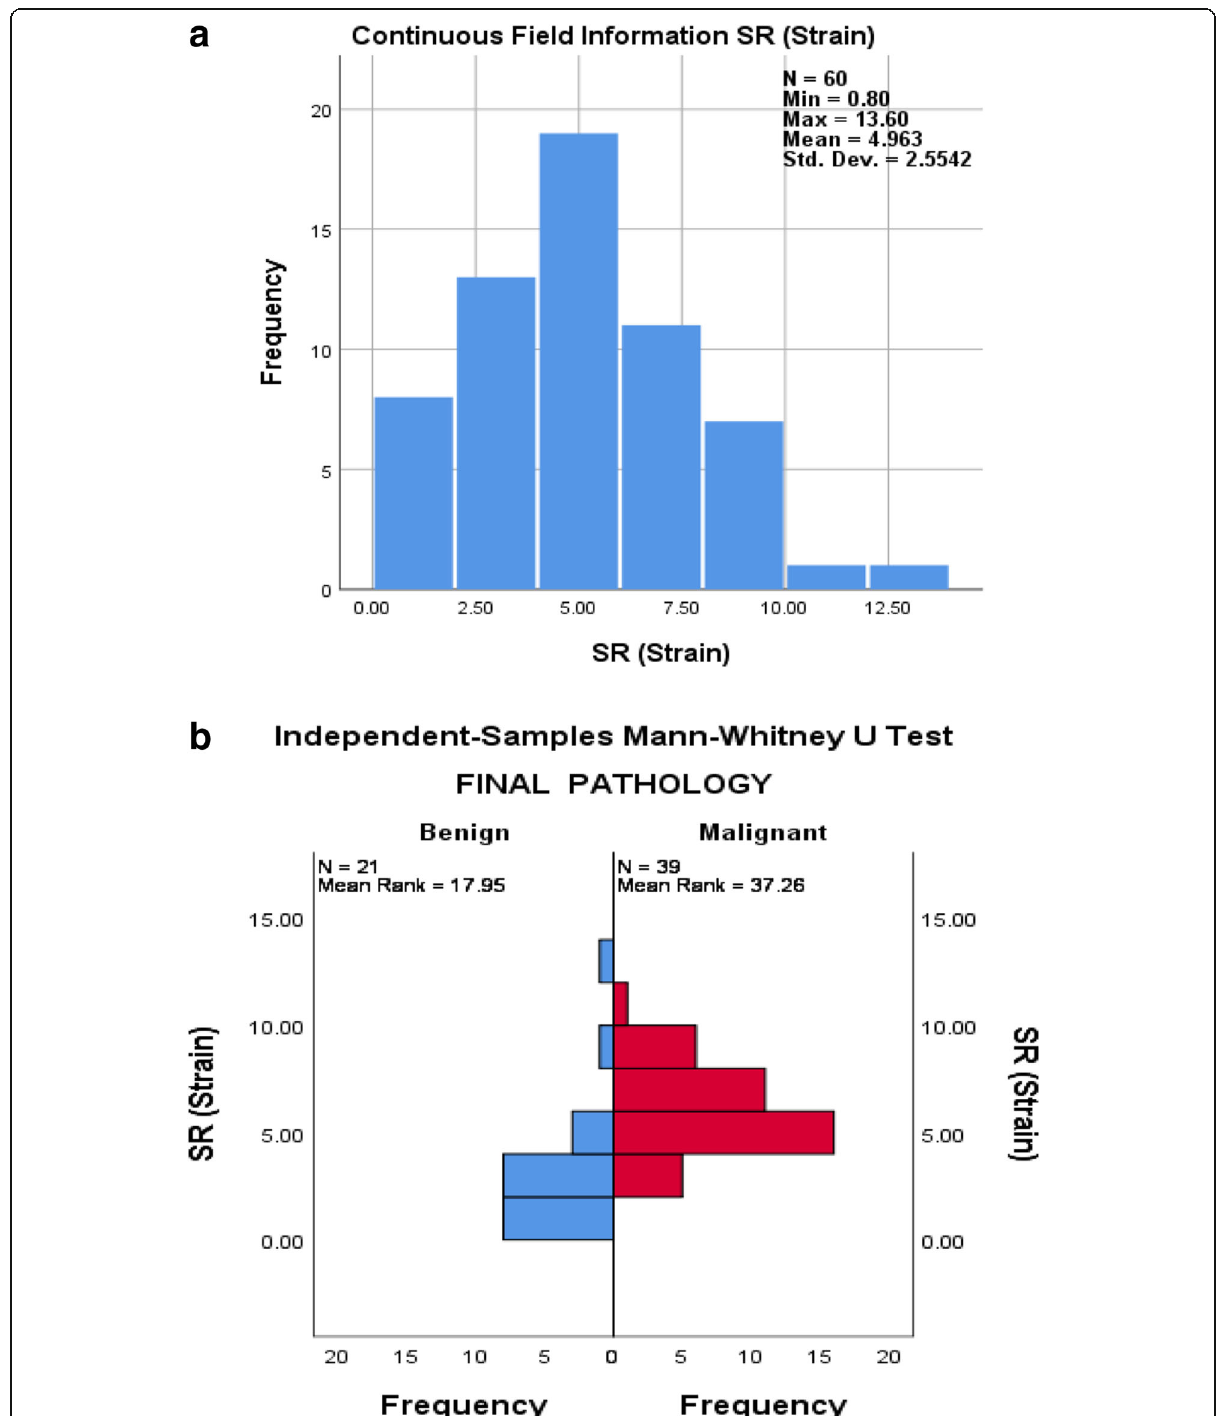
Fig. 4 a Distribution of SR values for the examined nodes. b Distribution of SR values for benign and malignant